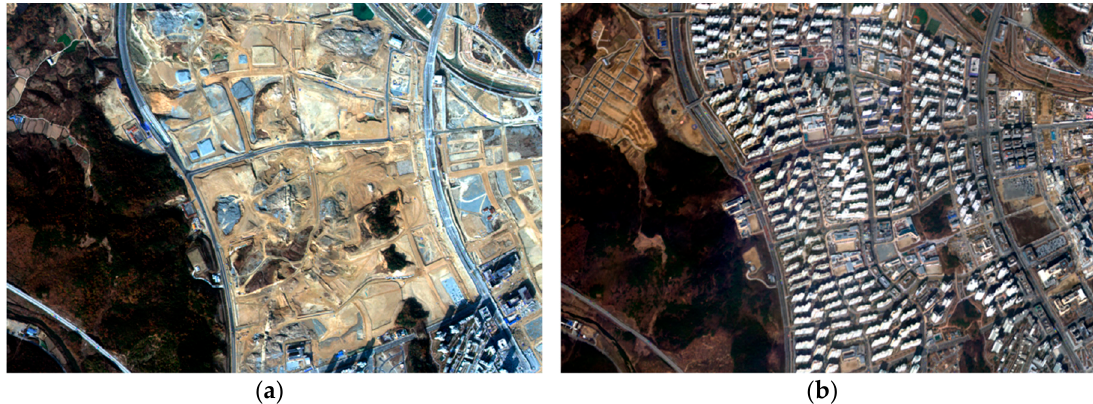
Figure 2. The first subset from KOMPSAT-3 images acquired over Sejong City, South Korea, in ( a ) 16 November 2013, and ( b ) 26 February 2019.